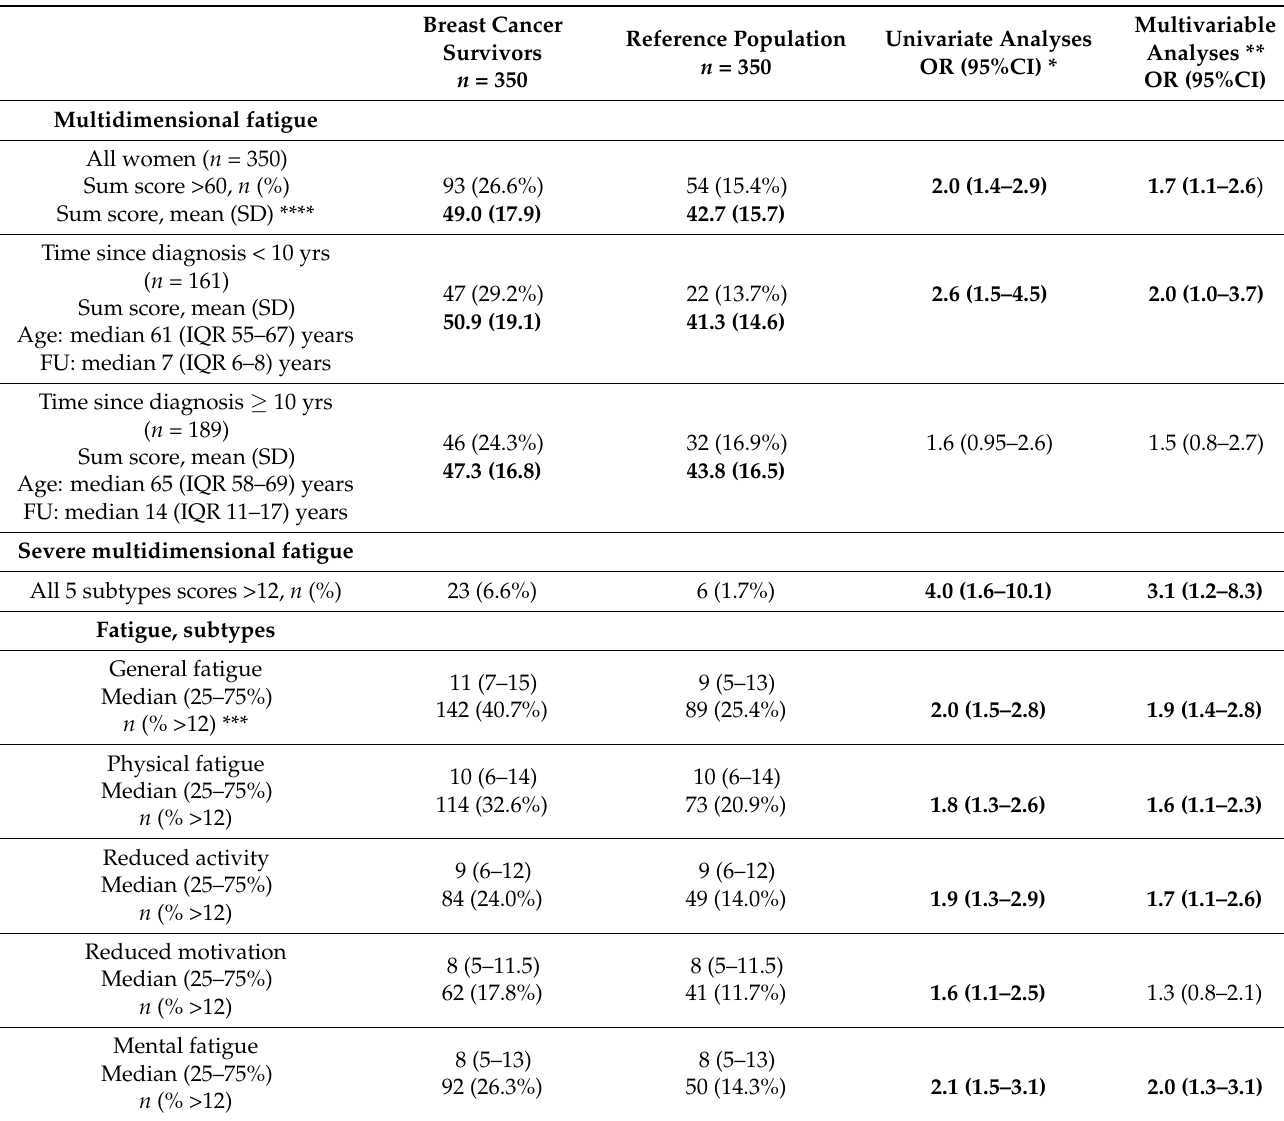
Table 2. Scores on fatigue amongst breast cancer survivors ( n = 350) in comparison to a reference population ( n = 350), measured with the MFI-20